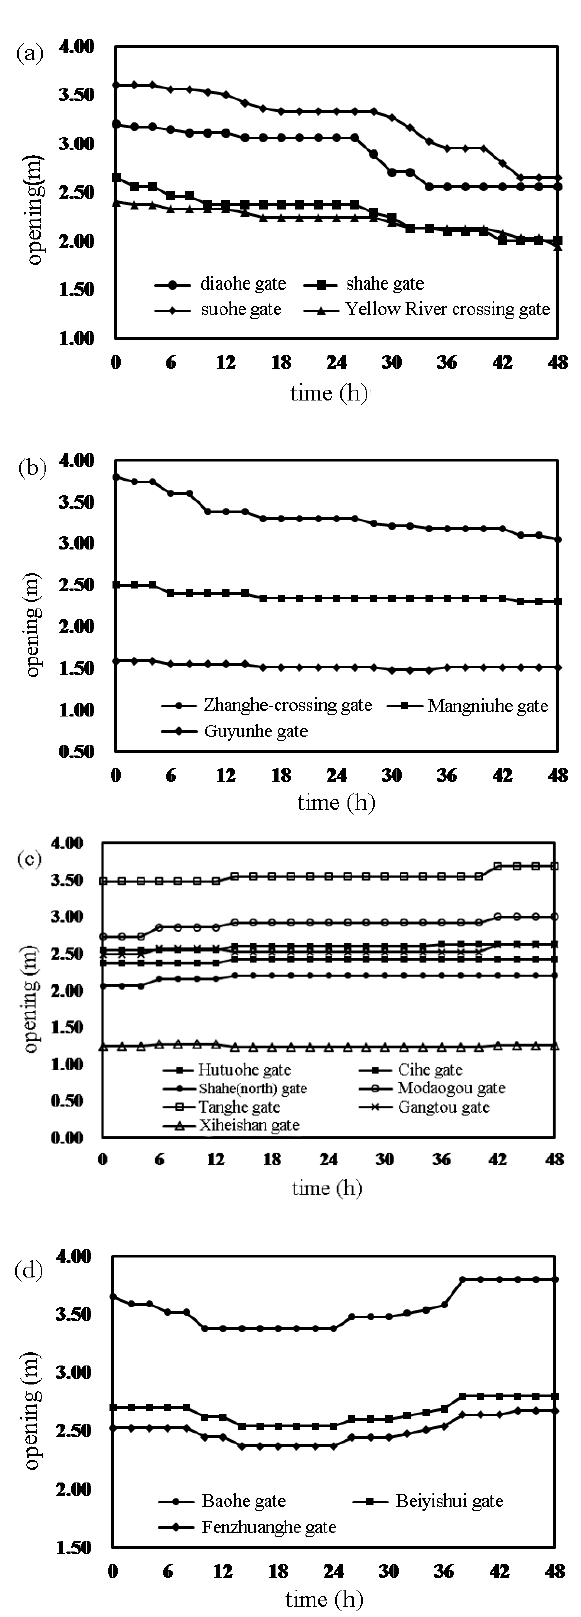
Figure 6. Variations of the check gate openings. ( a ) check gates from head to Yellow River; ( b ) check gates from Zhanghe to Guyunhe; ( c ) check gates from Hutuohe to Xiheishan; ( d ) check gates from Baohe to Fenzhuanghe. Table 3. Comparison of the total times of gate adjustments.